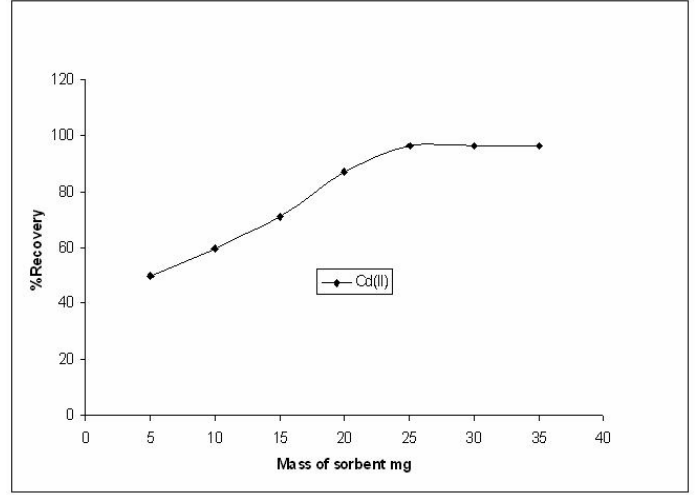
Figure 6. Effect of sorbent mass on analyte recovery .